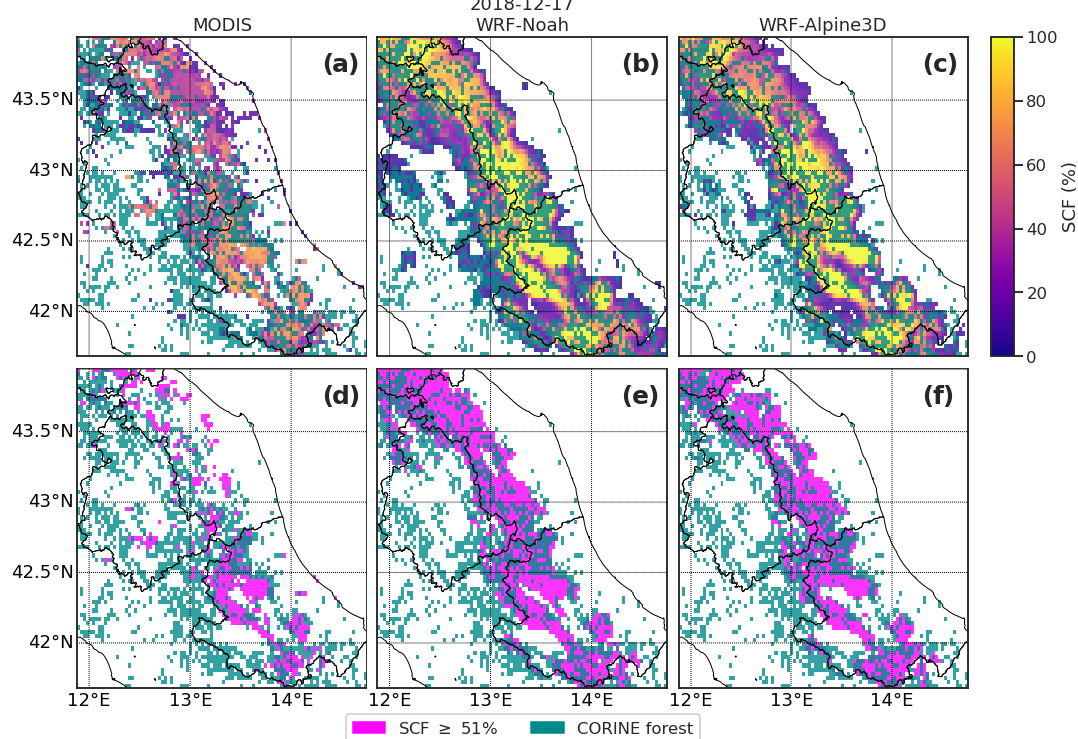
Figure 7. (a, b, c) MODIS, WRF–Noah and WRF–Alpine3D snow cover fraction maps. (d, e, f) MODIS, WRF–Noah and WRF–Alpine3D snow cover area maps derived by applying a threshold of 51% to the corresponding snow cover fraction maps. CORINE broadleaved-forest, coniferous-forest, and mixed-forest classes aggregated and reprojected from the original 100m resolution to a 3km resolution are also